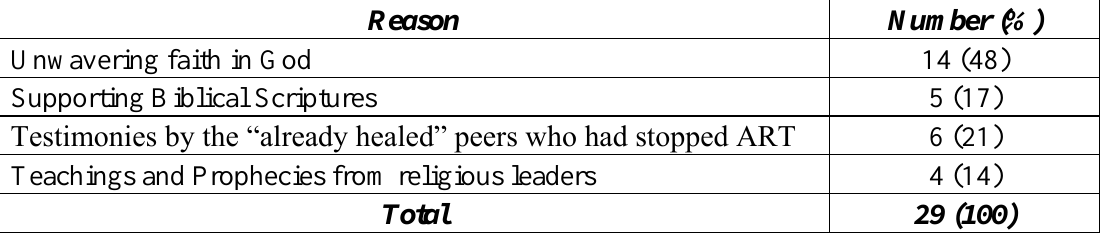
Table 2. Reasons why high religiosity can precipitate non-adherence to antiretrovirals (ARVs) (n =